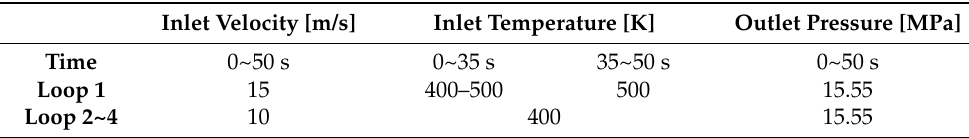
Figure 11. The quantitative distribution of the additional PIPEs at the core inlet/outlet planes. TRACE first runs a Steady-State (SS) simulation. During the SS, the inlet velocity at loop1 is 15 m/s. Inlet velocities of the other three loops are identical to 10 m/s. The inlet coolant temperature is 400 K. The outlet pressure is 15.55 MPa. After the SS, a TRACE transient (TS) simulation is carried out. The total problem time is 50.0 s. The boundary conditions for the transient are given in Table 1.